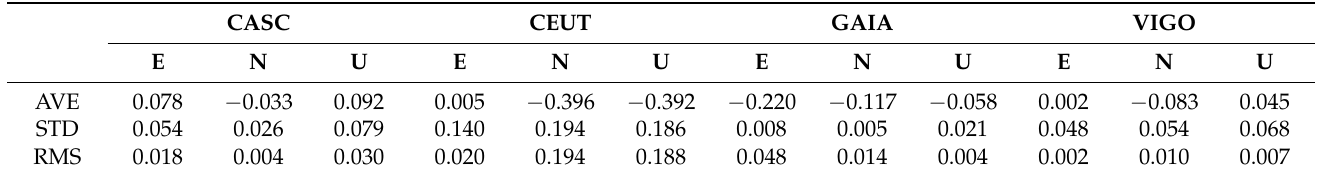
Table 12. Statistics results from the Test